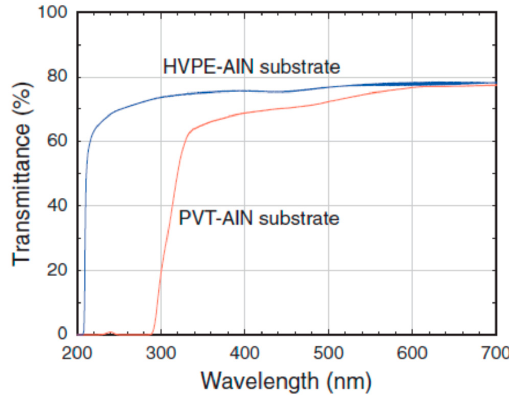
Figure 3. External optical transmission spectra of physical vapor transport (PVT)- and hydride vapor phase epitaxy (HVPE)-AlN substrates measured at RT in air. Substrates of the same thickness and surface polish state were used. Reprinted with permission from [57]. Copyright 2012, The Japan Society of Applied Physics.